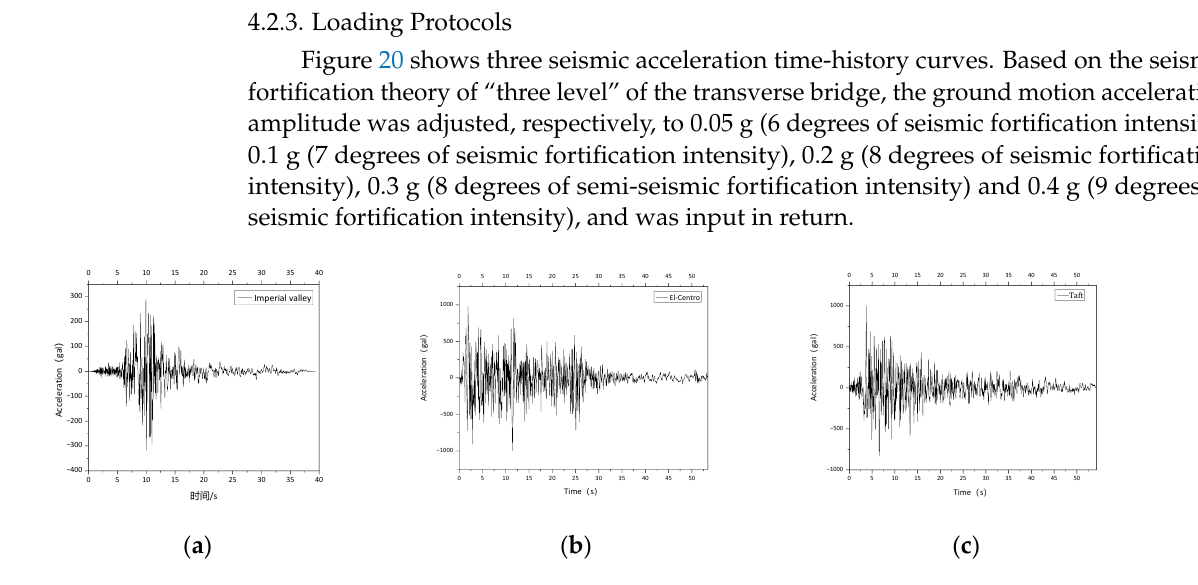
Figure 20. Seismic wave acceleration time-history curve. ( a ) Imperial valley seismic wave; ( b ) El- Centro seismic wave; ( c ) Taft seismic wave.